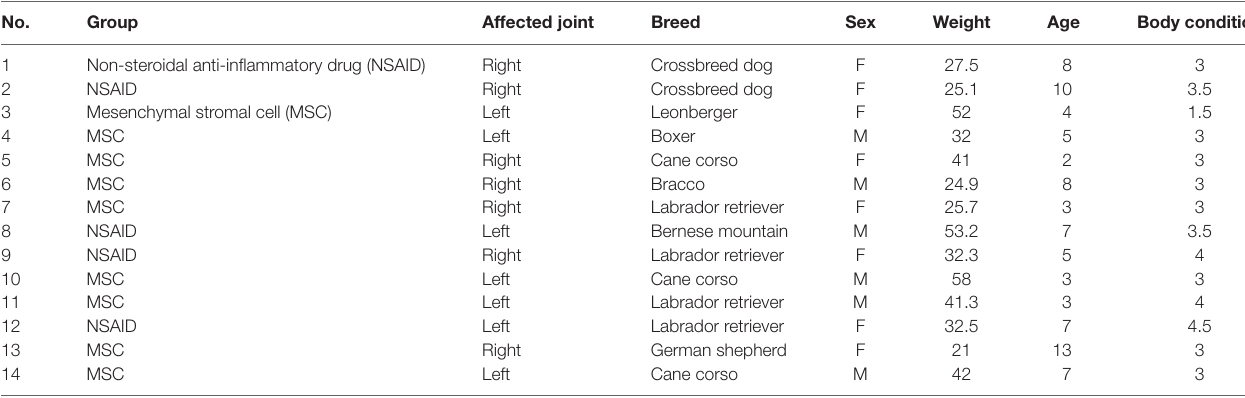
TaBlE 3 | Inclusion data of the